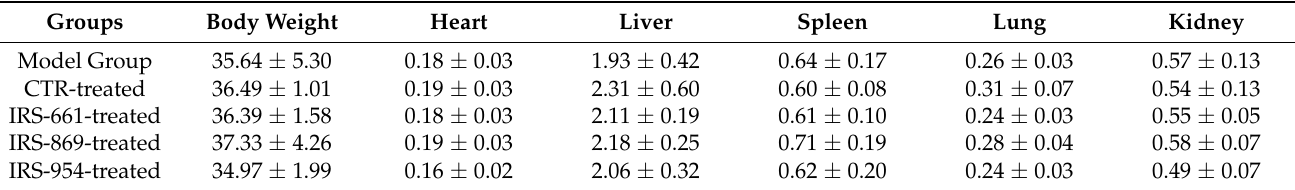
Table 1. Weight of body and main organs in each group.